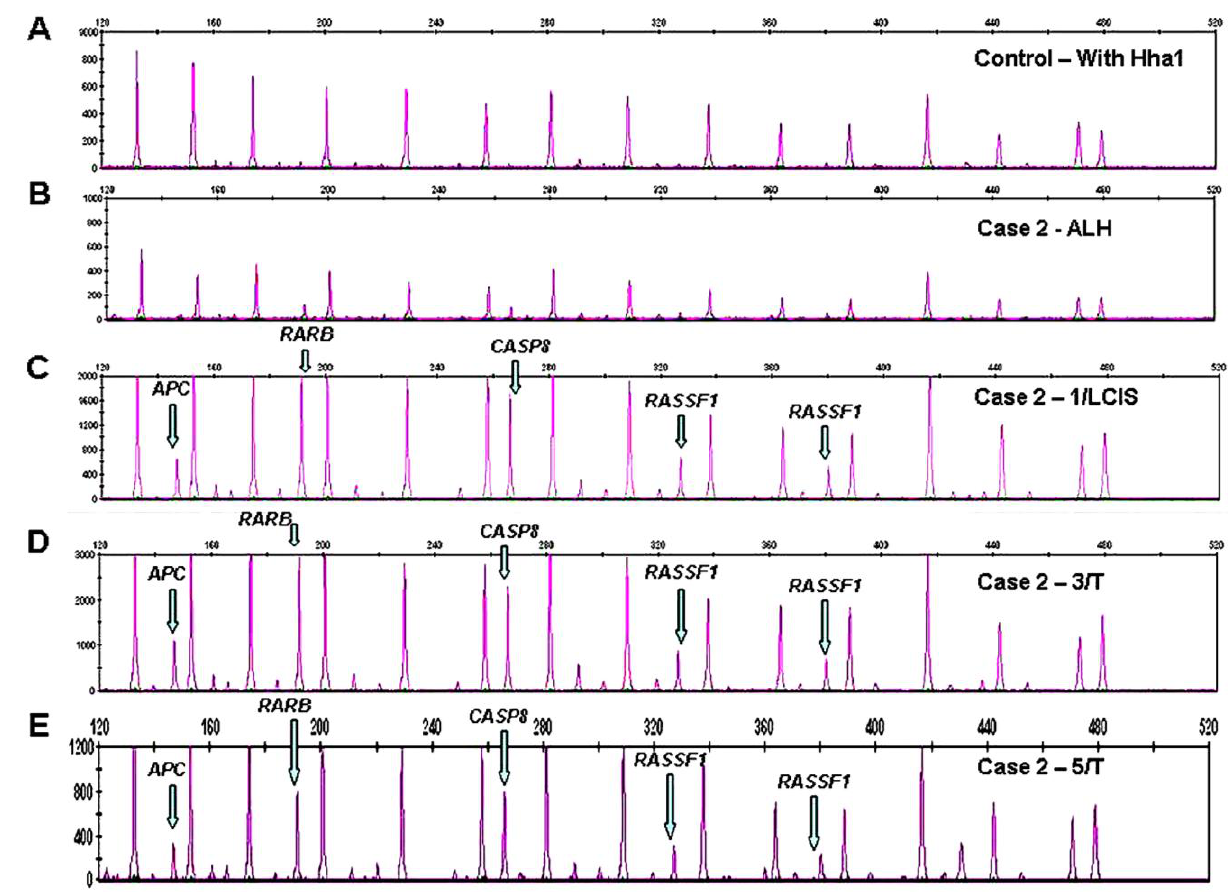
Figure 1. Methylation-Specific Multiplex Ligation Dependent Probe